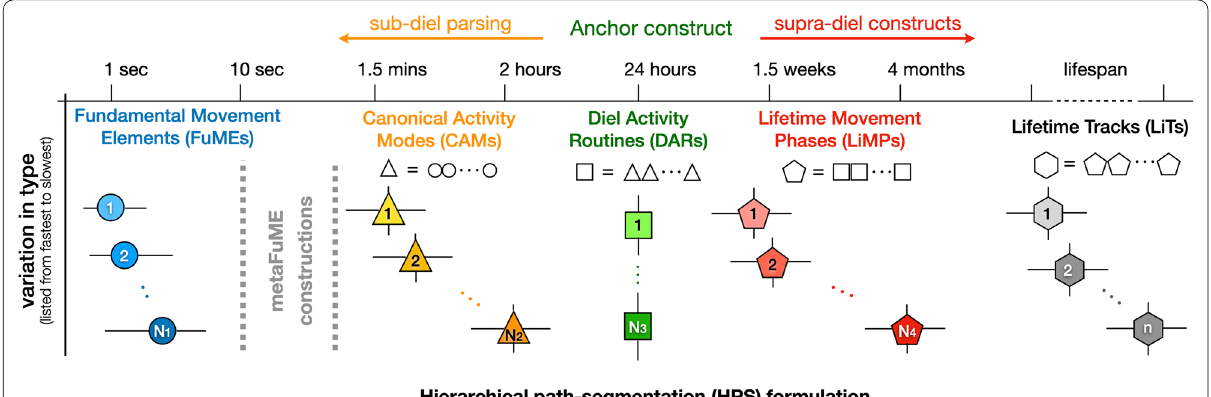
Fig. 1 A graphical depiction of a hierarchical path-segmentation (HPS) formulation that classifies segments of the lifetime tracks of individuals at four biologically relevant scales. The indicated time scales on the horizontal axis at the top of the diagram are mostly applicable to medium and large terrestrial animals, but need to be adjusted for some aerial and marine species, small vertebrates, and invertebrates. Round (blue), triangular (yellow to orange), square (green), pentagonal (red), and hexagonal (grey) icons are, respectively, used to represent N 1 FuME types, N 2 CAM types, N N 3 DAR types, 4 LiMP types, and an open-ended number of n LiT types (one for the lifetime of each movement group type to which an individual can belong). Horizontal whiskers on icons represent variations in the length of examples of the same type within a category. Only DARs have fixed duration. Vertical whiskers indicate some building-block variation within the same type, except for FuMEs which are much more stereotyped, and hence much less variable within types than other segmentation categories. Color shades within categories represent different types within those categories. Colorless strings of icons indicate how each category can be considered as a string of the next lower category elements (i.e., shapes and general color denote hierarchical level, while different shades of the same color indicate within level variation). Because FuMEs are hard to identify using relocation data only, a hierarchical segmentation of lifetime tracks will typically be supported by a statistically defined metaFuME